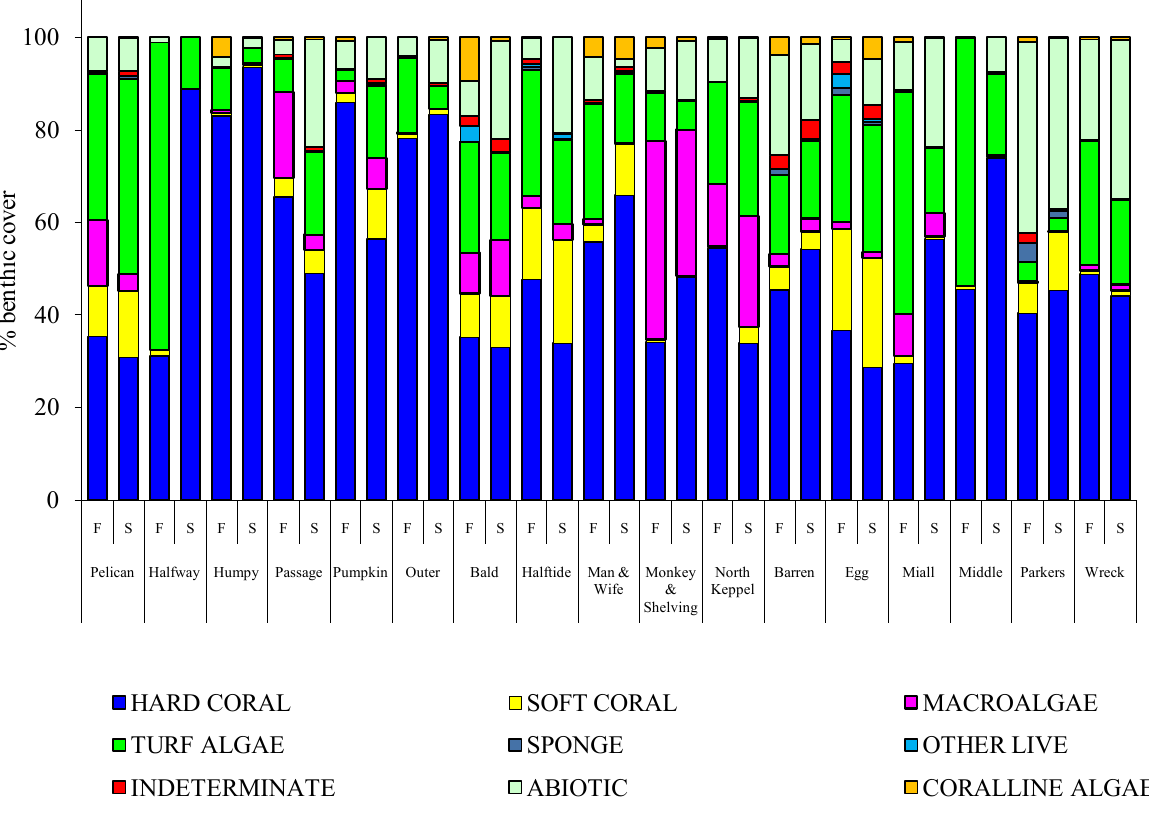
Figure 2. Percentage benthic cover (percentage of total benthic cover) on reef flats (F) and slopes (S) in the